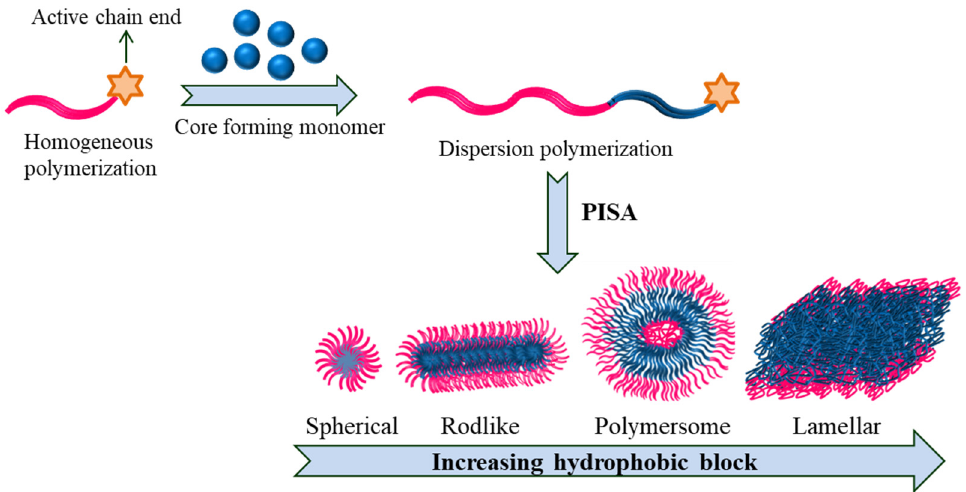
Figure 12. PISA depicting varied shape transition in block copolymers.